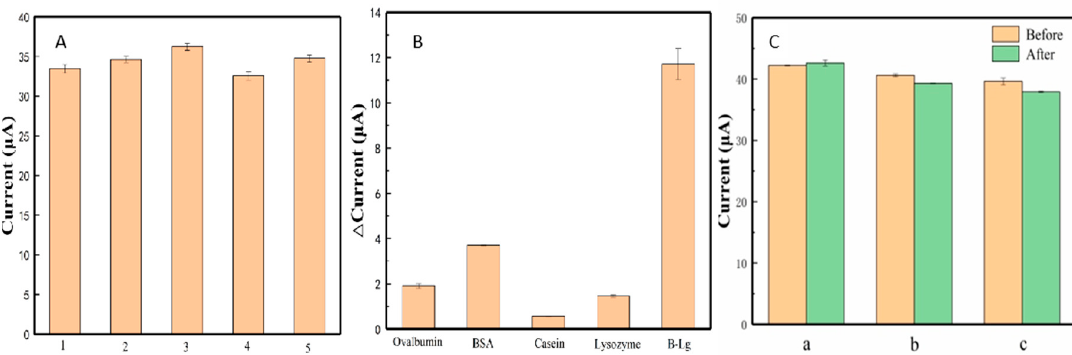
Figure 7. Results of ( A ) reproducibility, ( B ) specificity (0.025 ng/mL β -Lg, ovalbumin, BSA, casein, lysozyme), and ( C ) stability study on the electrochemical sensor.